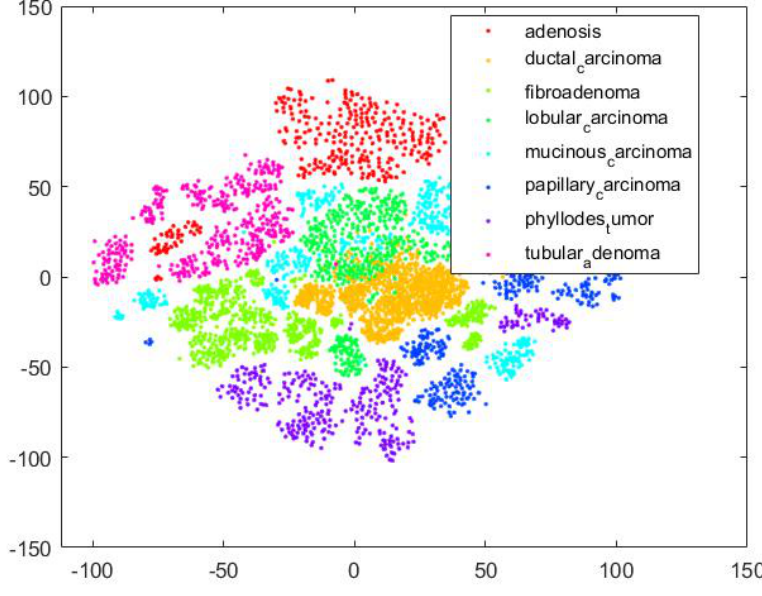
Figure 18. T-SNE visualization to illustrate that our proposed MPIFR method adequately discrimi- nates between the eight target BC classes in feature space .